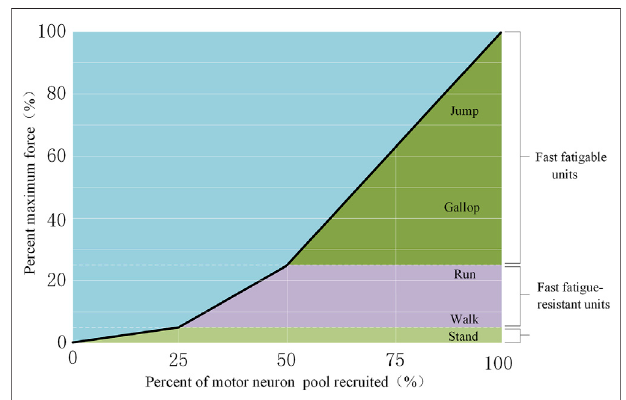
FIGURE 2 | Recruitment of motor neurons for different movements (Purves et al.,